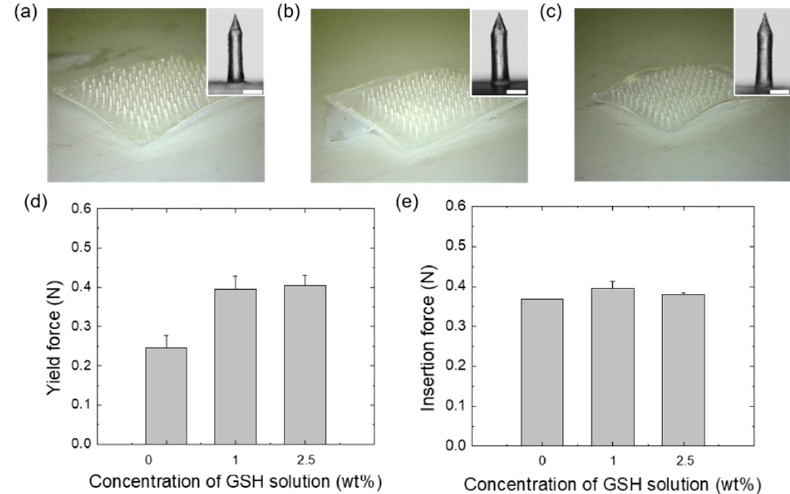
Figure 4. Photographs for ( a ) GSH 0 -HA MN, ( b ) GSH 1 -HA MN, and ( c ) GSH 2.5 -HA MN patches prepared from HA solutions with different GSH concentrations (0%, 1%, and 2.5%, respectively). Scale bar = 200 µm. ( d ) Yield force and ( e ) insertion force of GSH-HA MNs.